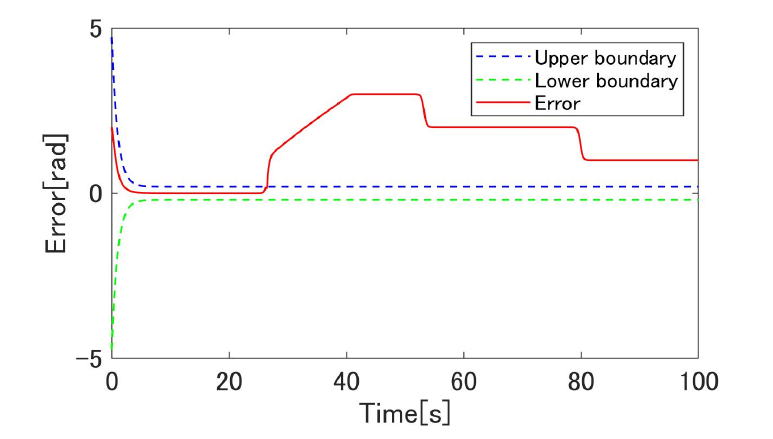
Figure 19. The error e and boundary functions without using the observers.